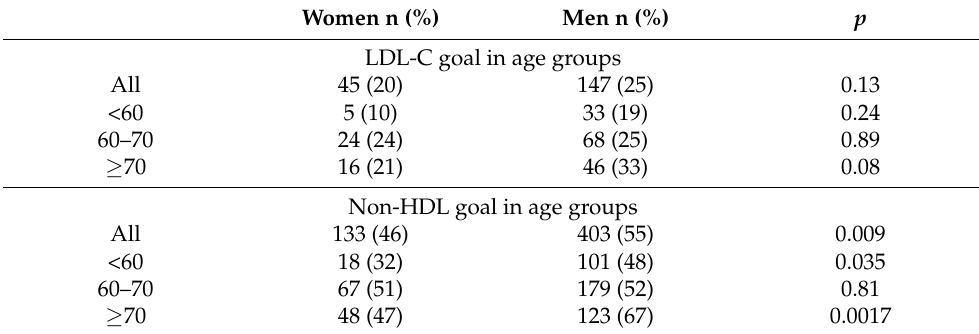
Table 4. The achievement of target LDL-C level and non-HDL-C in age groups in women and men during the follow-up